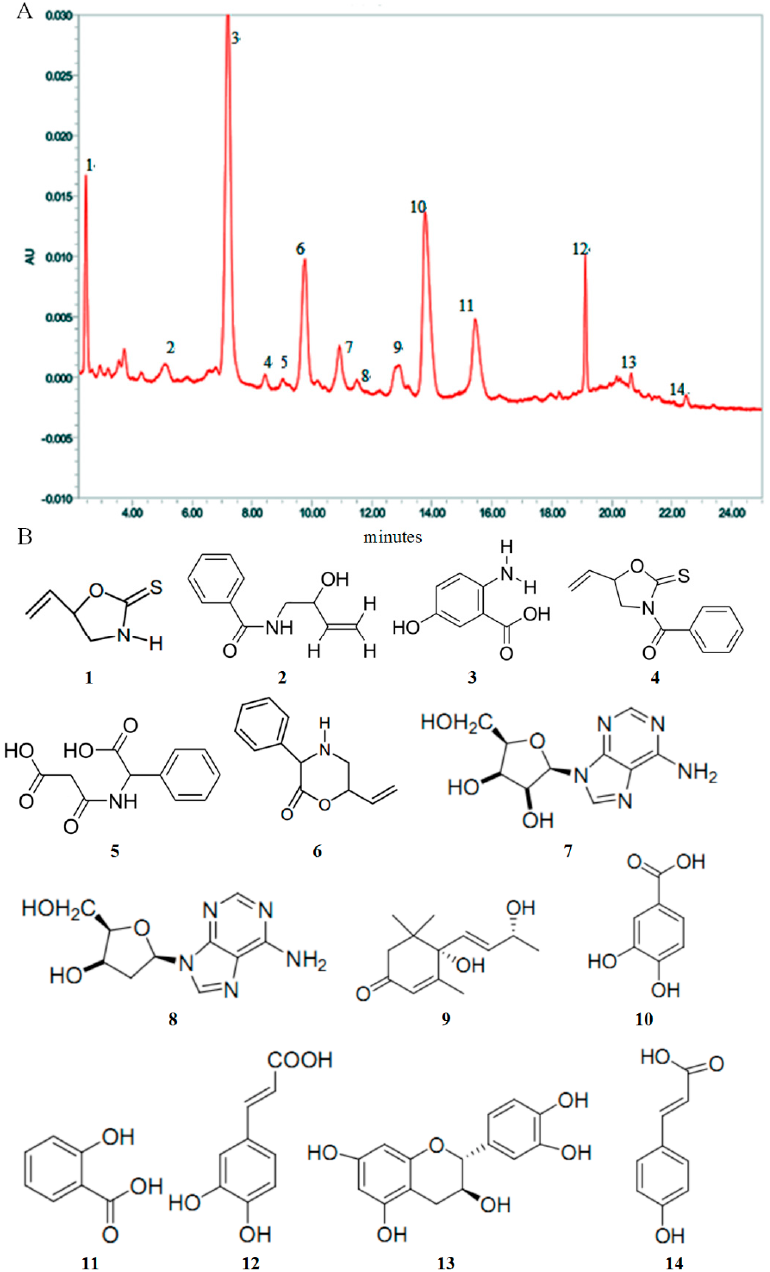
Figure 1. ( A ) The chromatographic profile of aqueous extract from Orychophragmus violaceus (AEOV) analyzed by HPLC; ( B ) Chemical structure of the main constituents of AEOV. analyzed by HPLC; ( B ) Chemical structure of the main constituents of